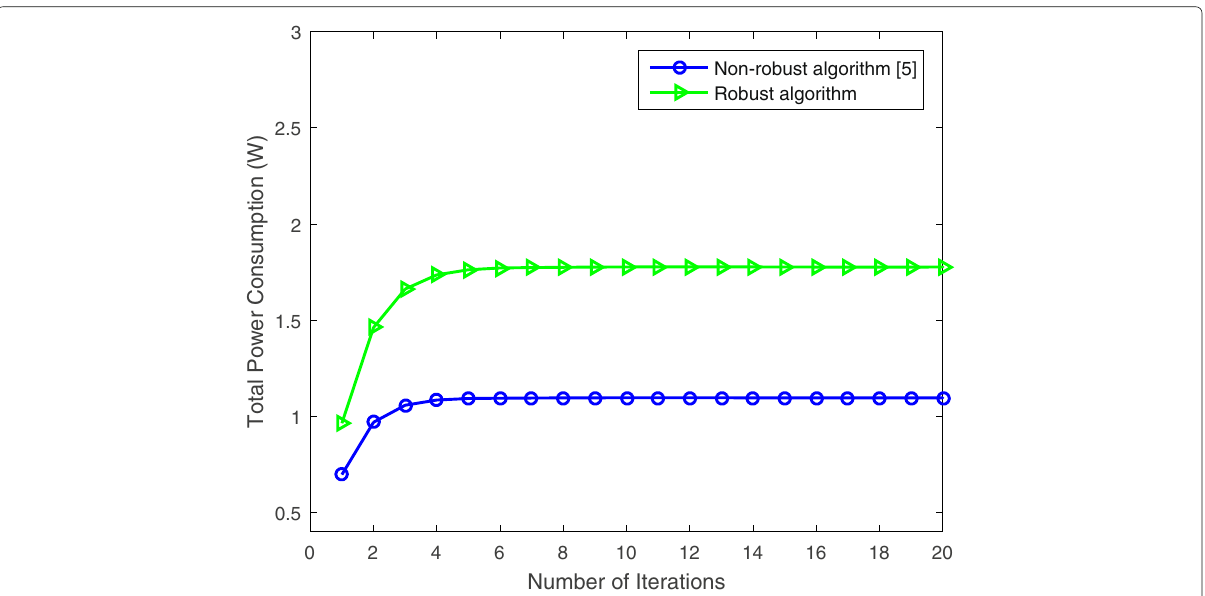
Fig. 5 Comparison of total power consumption between robust and non-robust PA